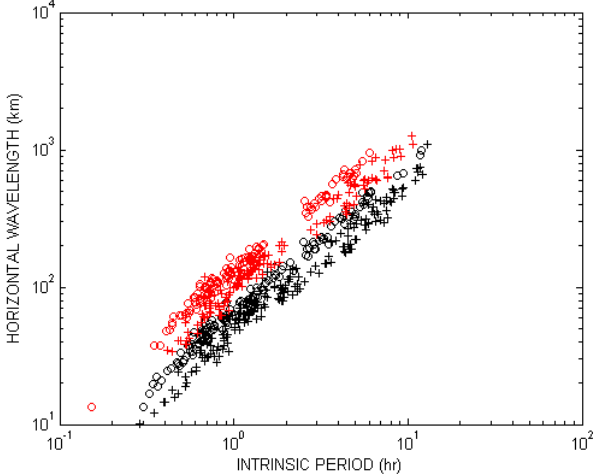
Fig.14 Horizontal wavelength versus intrinsic period of upward moving gravity wave Fig. 14. Horizontal wavelength versus intrinsic period of upward packets of winter data set. Wave packets obtained by window T2Z4, T3aZ4, moving gravity wave packets of winter data set. Wave packets ob- T3bZ4, T3cZ4 and T4Z4 were denoted by ‘cross’ ; Wave packets obtained by tained by window T2Z4, T3aZ4, T3bZ4, T3cZ4 and T4Z4 were window T2Z5, T3aZ5, T3bZ5, T3cZ5 and T4Z5 were denoted by ‘open denoted by cross; Wave packets obtained by window T2Z5, T3aZ5, circle’. Red color symbols represent the model with VB-period of 5 min, and T3bZ5, T3cZ5 and T4Z5 were denoted by open circle. Red colour black color symbols represent the model of VB-period of 10 min. symbols represent the model with VB-period of 5min, and black colour symbols represent the model of VB-period of